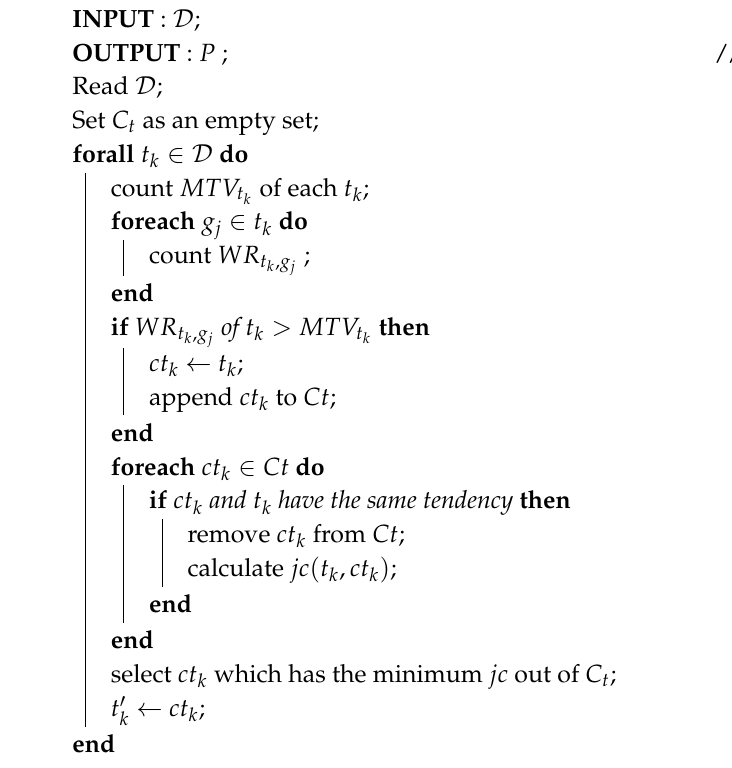
Algorithm 2: Procedure of destination record selection for partial